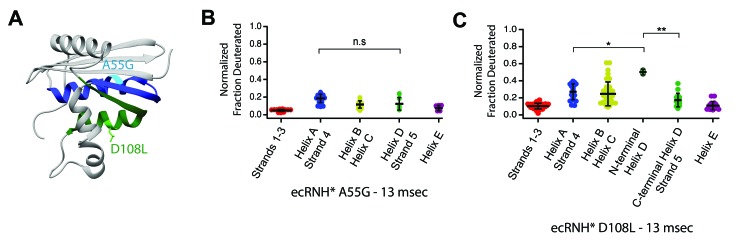
Engineered mutations to alter the folding pathway of ecRNH*.(A) Crystal structure of E. coli RNase H (PDB: 2RN2) with mutations designed to alter intrinsic helicity (Katayanagi et al., 1992). A55G, located in Helix A (blue), is colored in cyan. D108L, located in Helix D (green), is colored in light green. (B) Protection of peptides mapping to distinct secondary structural elements of ecRNH* A55G at 13 msec after refolding. Bars represent the mean and standard deviation of each data set. p=0.0917 (n.s. = not significant, Welch’s unpaired T-test). (C) Protection of peptides mapping to distinct secondary structural elements of ecRNH* D108L at 13 msec after refolding. Bars represent the mean and standard deviation of each data set. *p=0.0044, **p=0.0016 (Welch’s unpaired T-test). Data for B and C represent aggregate data from three separate experiments.10.7554/eLife.38369.018Figure 5—source data 1.HX-MS data for ecRNH* A55G and ecRNH* D108L.